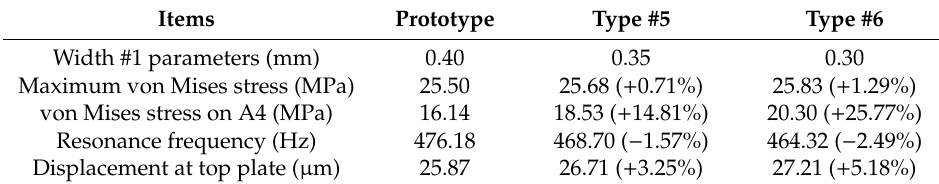
Figure 20. von Mises stress distribution on spring with different width #1 parameters. Table 5. Analysis result comparison between different width #1 parameters.